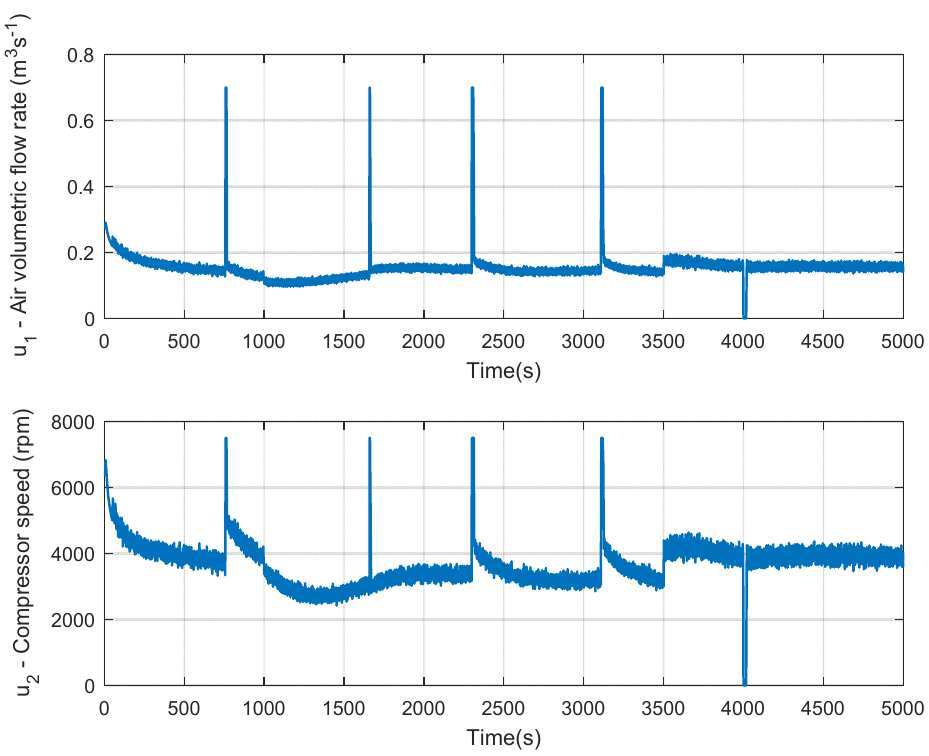
Figure 7. Control signals for tracking performance of VS DX A/C system with internal and external disturbances.